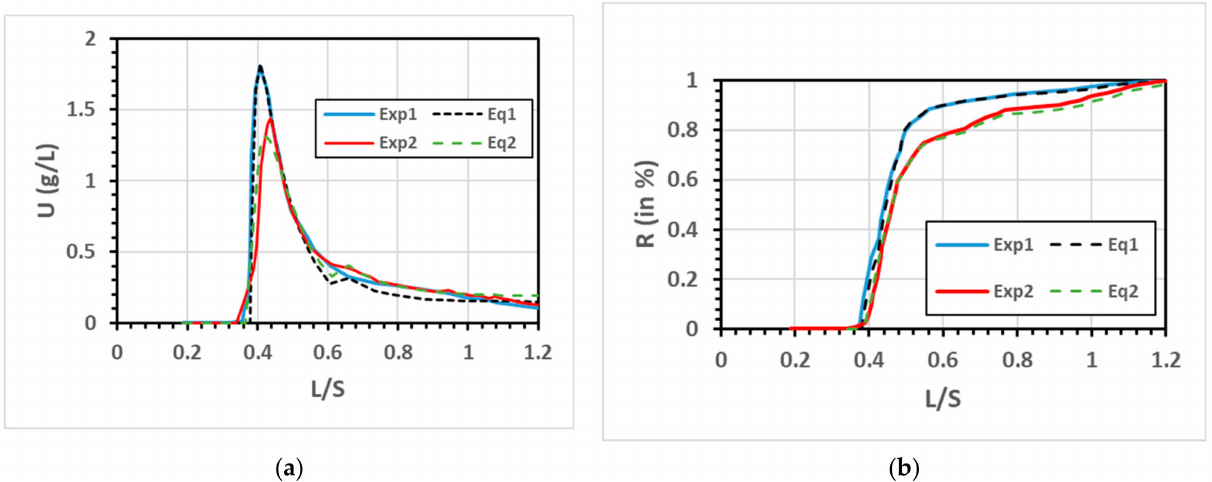
Figure 13. ( a ) Experimental uranium concentration curves fitted to the analytical model; ( b ) cor- responding ore recovery curves adjusted by the same bi-compartmental exponential model (Exp1: H 2 SO 4 = 30 g/L; Exp1: H 2 SO 4 = 20 g/L). Experimental data ( left ) came from Figure 3; the